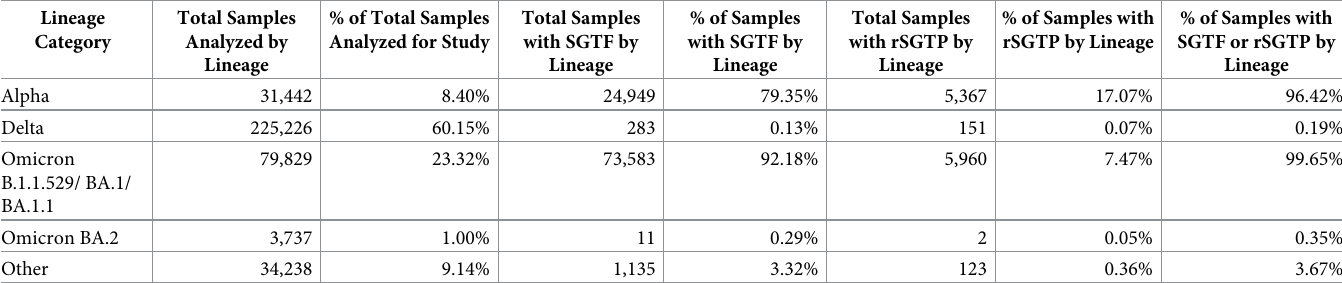
Table 1. Rates of rSGTP and SGTF in WGS confirmed lineages.